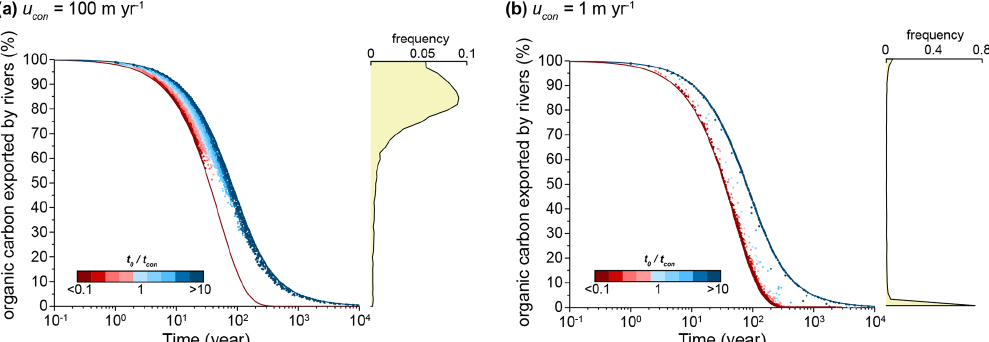
Figure 5. The proportion of landslide-mobilized OC that is exported by rivers for a population of co-seismic landslides, plotted as a function of the total time the landslides remain in the catchment. All results are for a single pool model of OC oxidation and different values of the connection velocity: (a) u con = 100myr − 1 , (b) u con = 1myr − 1 . Each dot is an individual landslide characterized by a combination of its connection time ( t con ) and fluvial export time ( t 0 ), and its position on the x axis is t tot = t con + t 0 . The color of each dot represents the ratio between the export time and the connection time. The blue line is the percentage of OC exported by rivers when t con = 0. In this case, the x axis corresponds to t 0 only. The red line represents the lower limit of the percentage of OC that could be exported by rivers for a given time. In this case, t 0 = 0 and the x axis corresponds to t con only. The histograms on the right of each plot represent the distribution of the percentage of OC exported by rivers from the scatter plot.